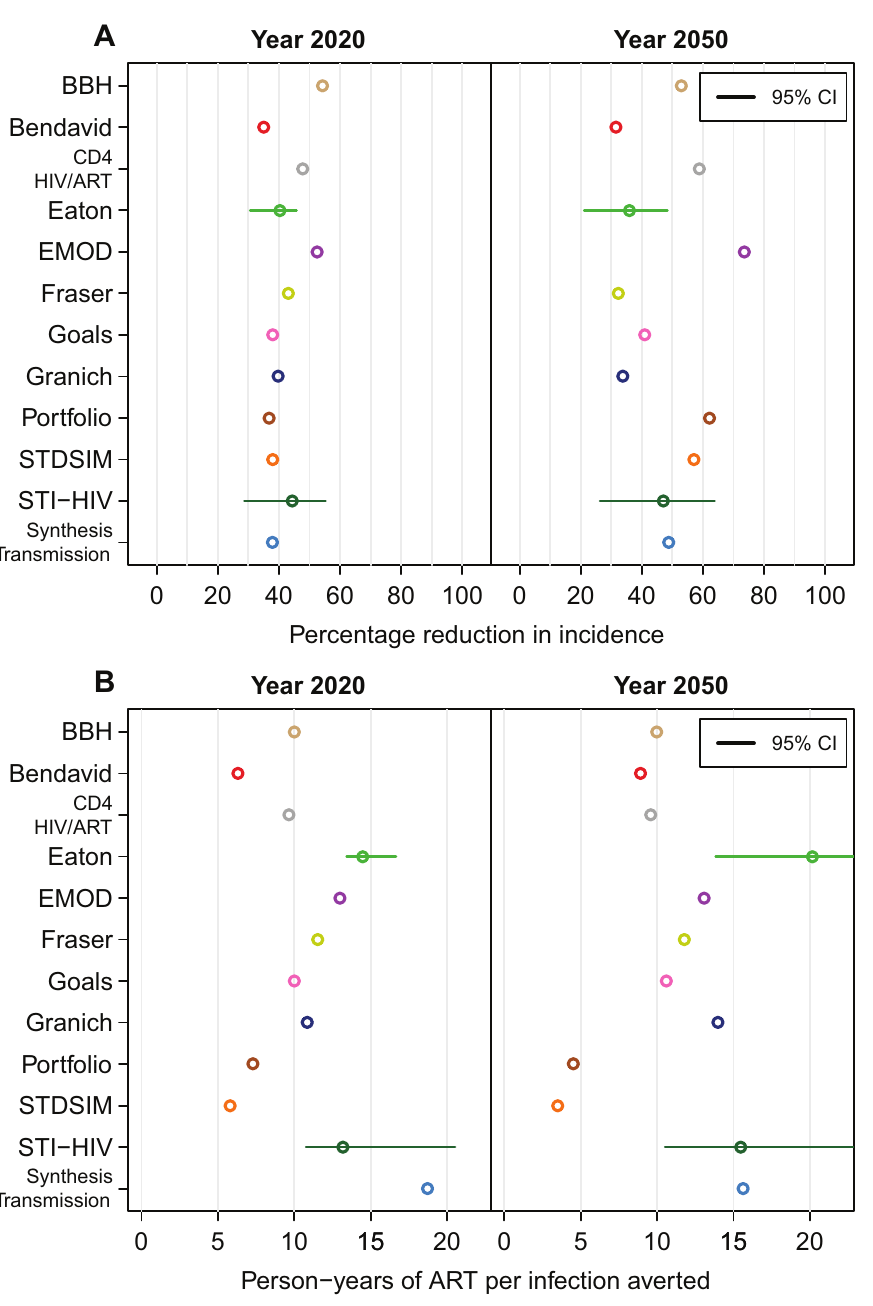
Figure 2. Impact of treatment for a scenario with eligibility at CD4 # 350 cells/ m l, 80% access, and 85% retention. (A) The percentage reduction in HIV incidence in the years 2020 and 2050 when eligibility for treatment is at CD4 count # 350 cells/ m l, 80% of individuals are treated, and 85% are retained on treatment after 3 y. (B) The cumulative number of person-years of ART provided per infection averted for the same scenario. Horizontal lines indicate 95% credible intervals (CI). For the Bendavid model, results in year 2040 are reported in the right